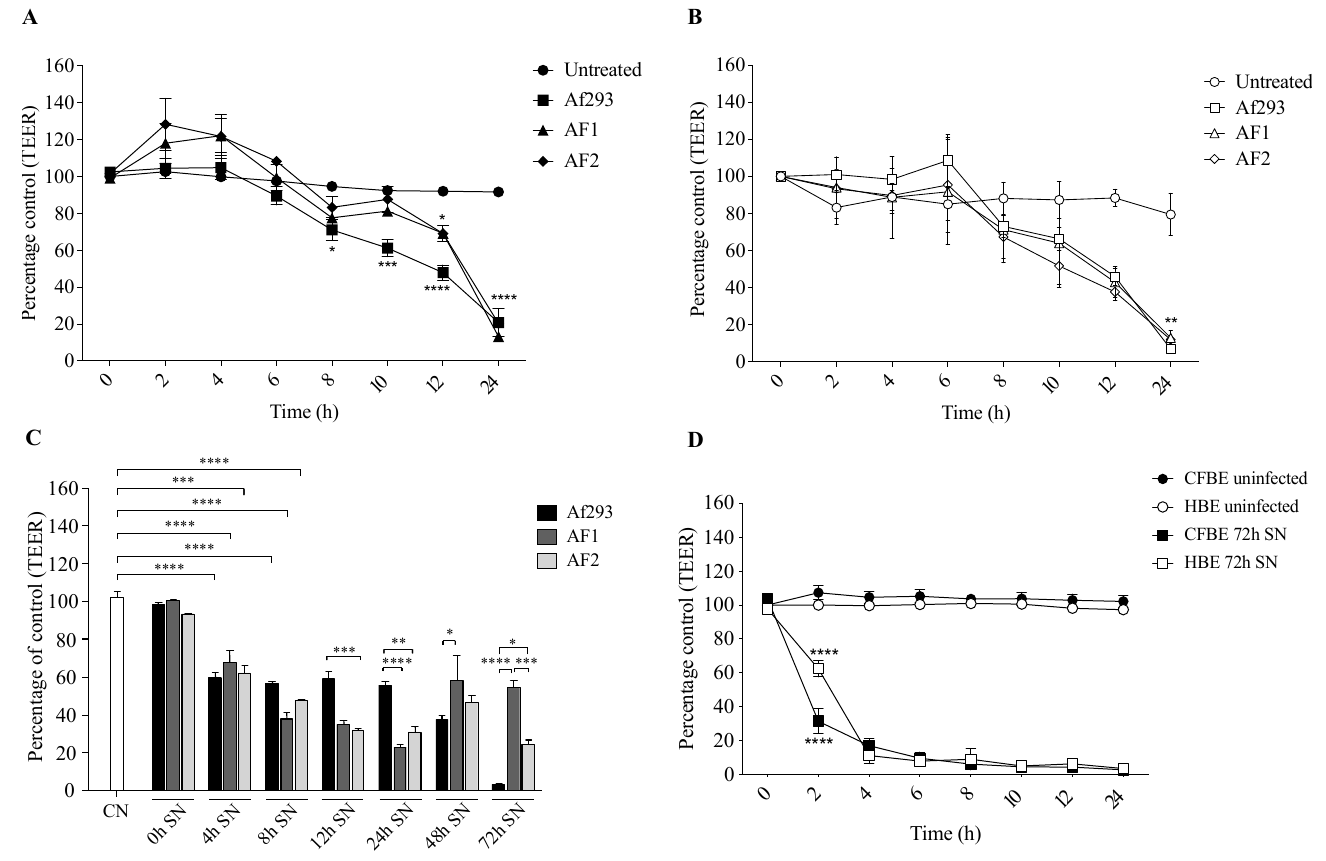
Figure 1. Integrity of CFBE and HBE monolayers following exposure to conidia or supernatants of A. fumigatus . ( A ) TEER values of CFBE monolayers untreated, infected with Af293 conidia, AF1 conidia and AF2 conidia at an MOI of 2:1. ( B ) TEER values of HBE monolayers untreated, infected with Af293 conidia, AF1 conidia and AF2 conidia at an MOI of 2:1. ( C ) Histogram presenting the percentage change from control TEERs of CFBE monolayers untreated (CN) and after 24 h exposure to 0, 4, 8, 12, 24, 48 and 72 h supernatants of Af293, AF1 and AF2. ( D ) TEER values of CFBE and HBE monolayers untreated and exposed to 72 h supernatants (SN) of Af293 over 24 h. Error bars represent standard error of at least three independent replicates. * p < 0.05, ** p < 0.01, *** p < 0.001, **** p < 0.0001.